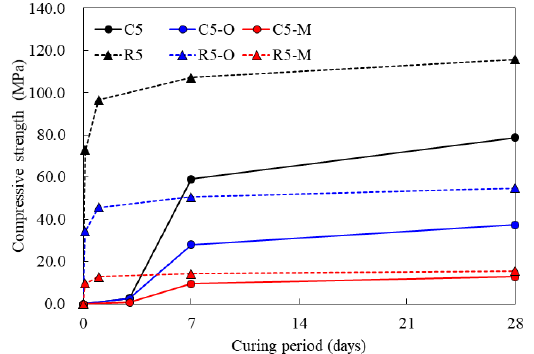
Figure 2. Compressive strength results.